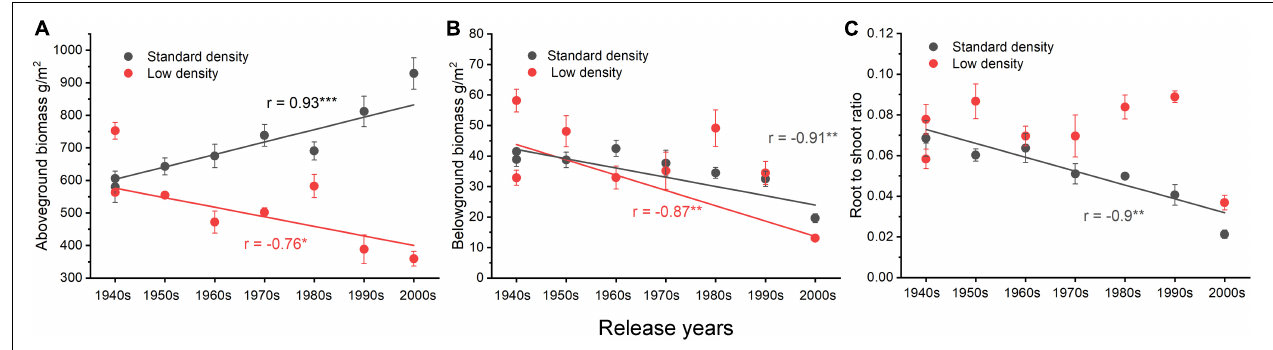
FIGURE 2 | Relationships between biomass and release year of eight cultivars in two planting densities. (A) The relationship between aboveground biomass and release time, (B) the relationship between belowground biomass and release time, and (C) the relationship between the root to shoot ratio and release time. Error bars indicate standard errors. * p ≤ 0.05, ** p ≤ 0.01, *** p ≤ 0.001.